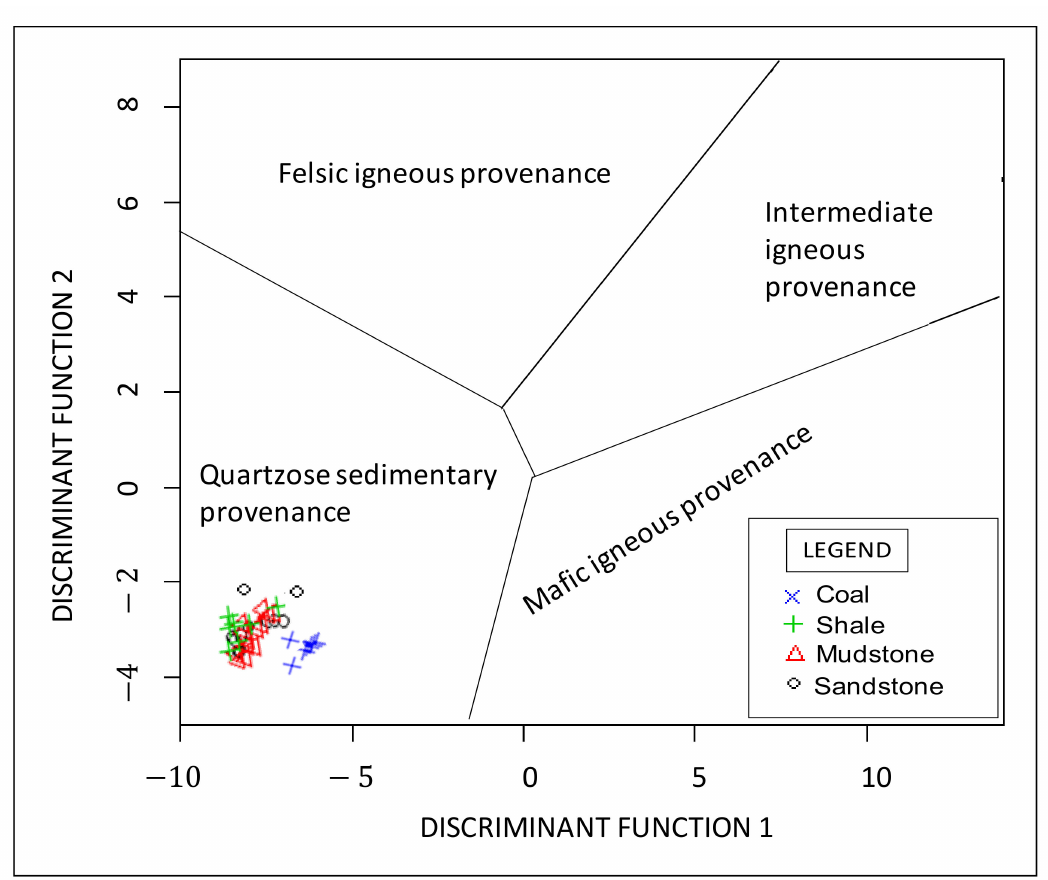
Figure 12. Major element Discriminant Function diagram for sedimentary provenance (shale, and coal samples (Background field after [30]). The discriminant functions are: Discriminant Function 1 = ( − 1.773 TiO 2 ) + (0.607 Al 2 O 3 ) + (0.760 Fe 2 O 3 ) + ( − 1.500 MgO) + (0.616 CaO) + (0.509 Na 2 O) + ( − 1.224 K 2 O) +( − 9.090); Discriminant Function 2 = (0.445 TiO 2 ) + (0.070 Al 2 O 3 ) + ( − 0.250 Fe 2 O 3 ) + ( − 1.142 MgO) + (0.438 CaO) + (1.475 Na 2 O) + ( − 1.426 K 2 O) +